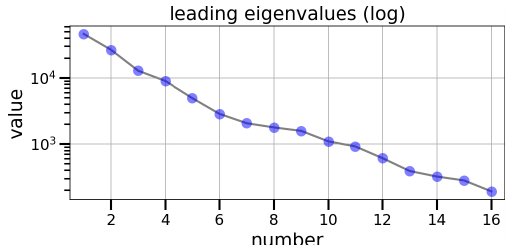
Figure 5. Leading eigenvalues of biogenic emissions for combined sensitivities (blue dots). Eigenvalues are plotted on a logarithmic